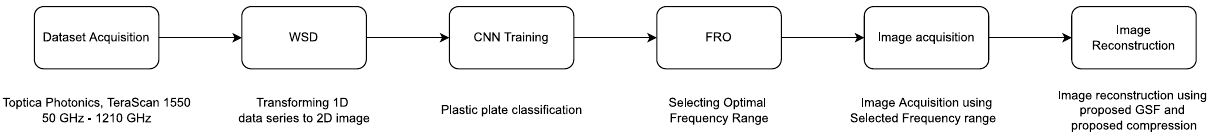
Figure 8. Principle of the proposed frequency range